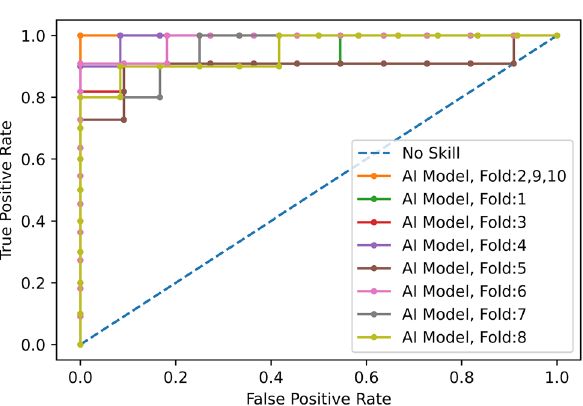
Figure 3. ROC curve for COVID-19 diagnosis (vs CAP and normal) using the proposed deep learning model and CT scans